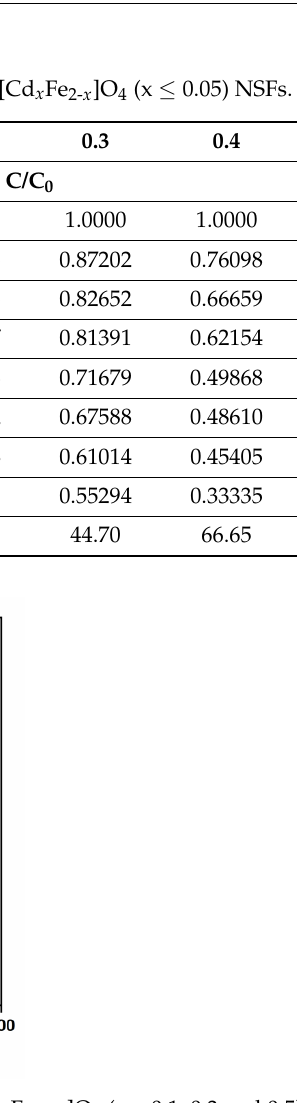
Figure 6. Variation of C/C 0 vs. time for (Mn 0.5 Zn 0.5 )[Cd x Fe 2 − x ]O 4 ( x = 0.1, 0.3 and 0.5) NSFs.